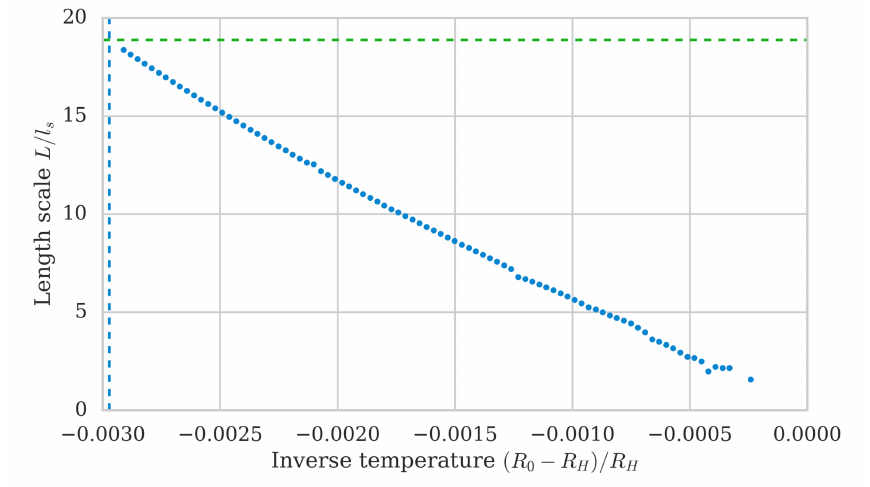
Figure 7 . Numerical estimation of the AdS string star length scale L (in string units) as a function of ( R ) /R . The numerical calculation was done for the d = 6 heterotic string. The blue 0 − R H H vertical line is the AdS Hagedorn temperature R scale L c